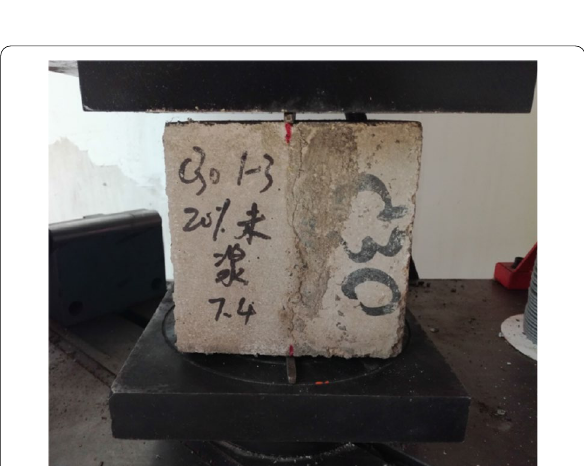
Fig. 6 Photograph of the splitting tensile strength test setup for bonding tensile strength